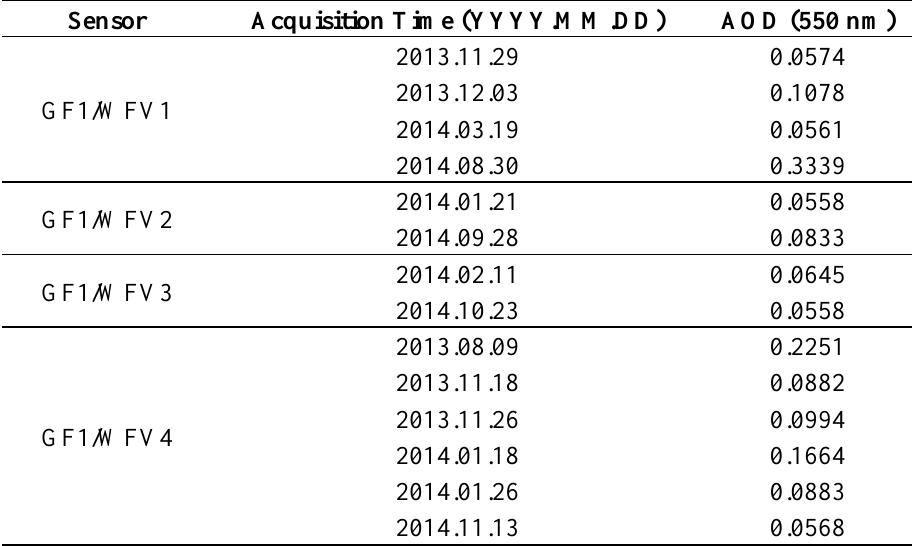
Table 9. Retrieved AOD for GF-1/WFV imagery.